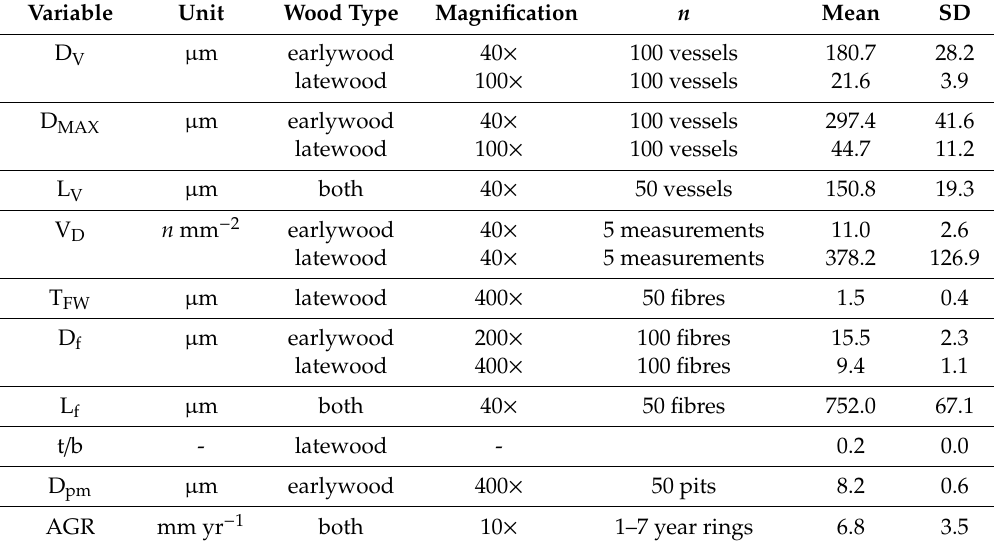
Table 1. Wood anatomical features measured in C. bungei . D V , vessel lumen diameter; D MAX ,maximum vessel lumen diameter; L V ,vessel element length; V D , vessel density; T FW , fibre wall thickness; D f , fibre lumen diameter; L f , fibre length; t / b , fibre wall thickness / diameter ratio; D pm , pit membrane diameter; AGR , annual diameter